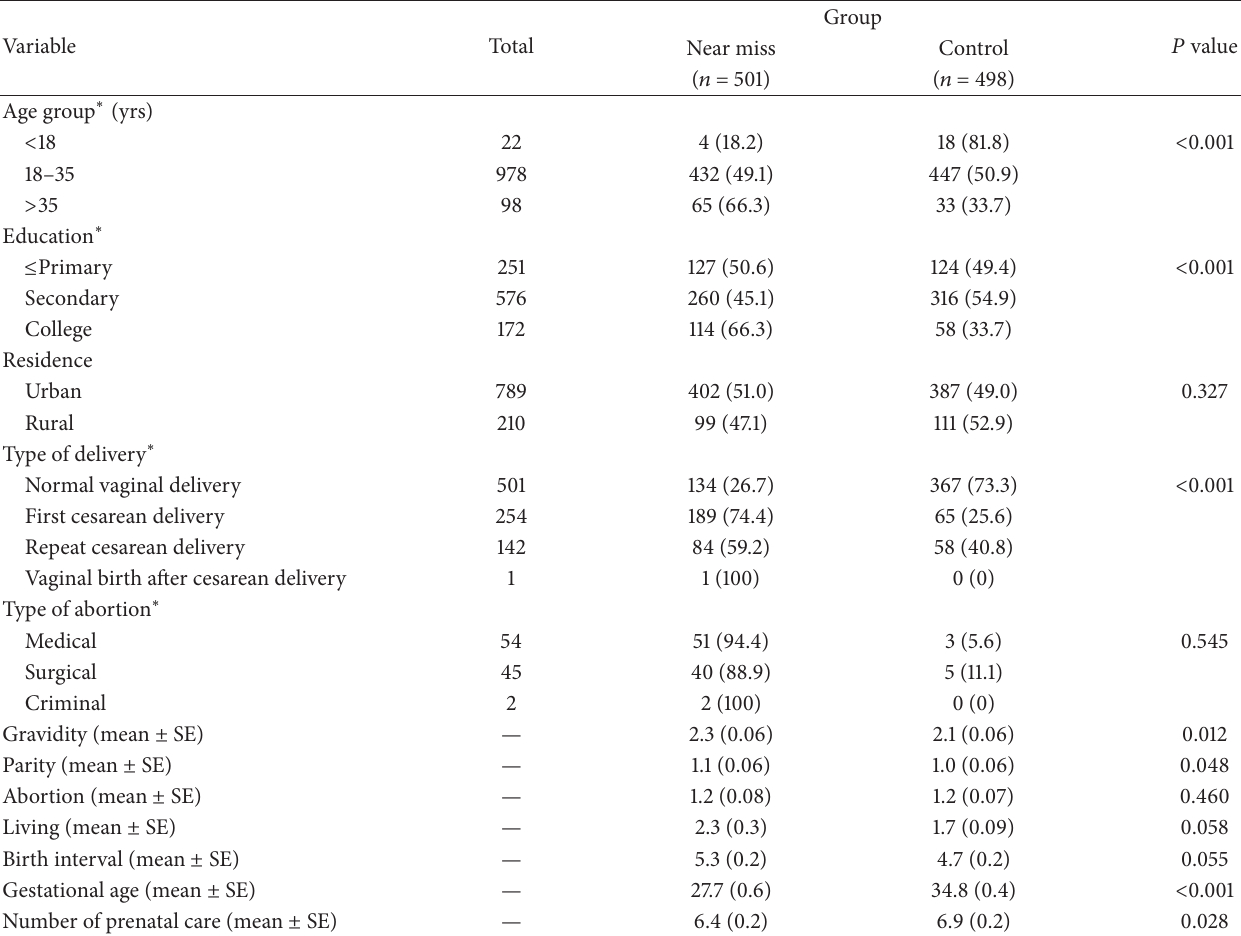
Table 2: Baseline and clinical characteristics in near miss and control